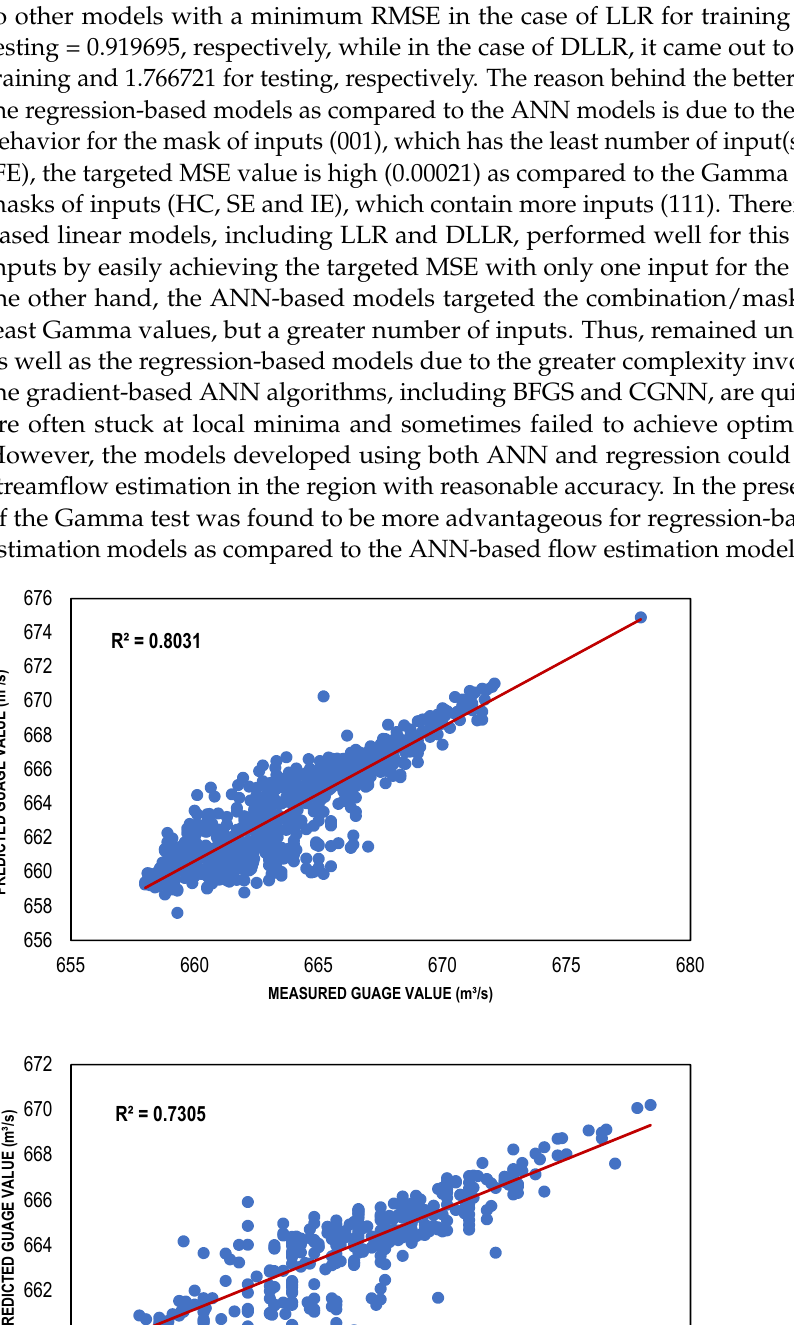
Figure 6. Best TLBP-based models (training and testing).